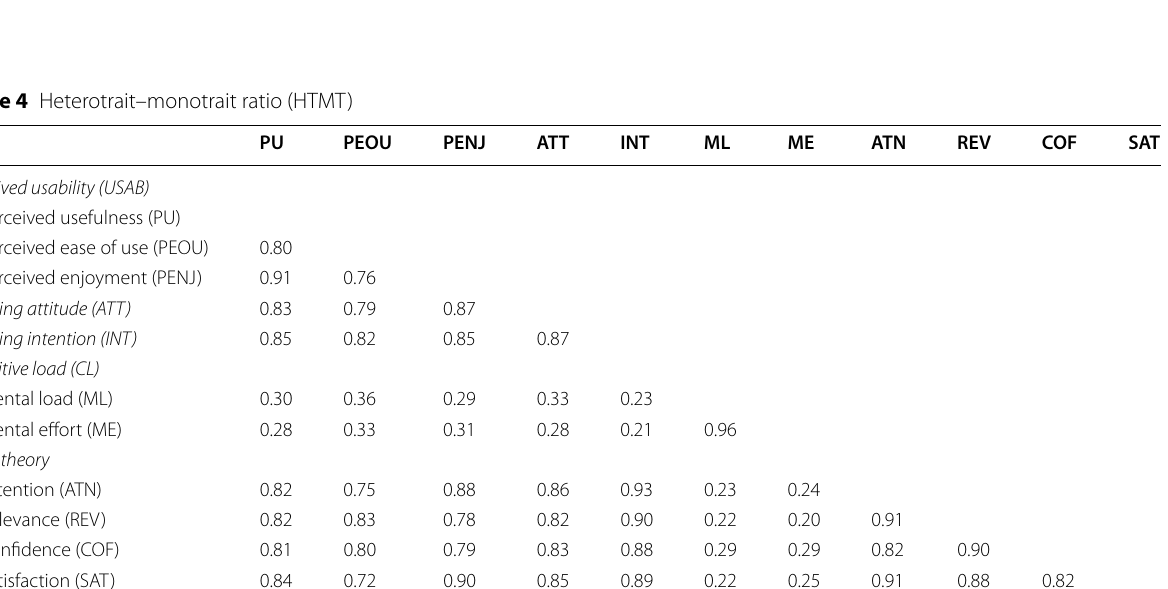
The bold values are the square root of the AVE of each latent variable